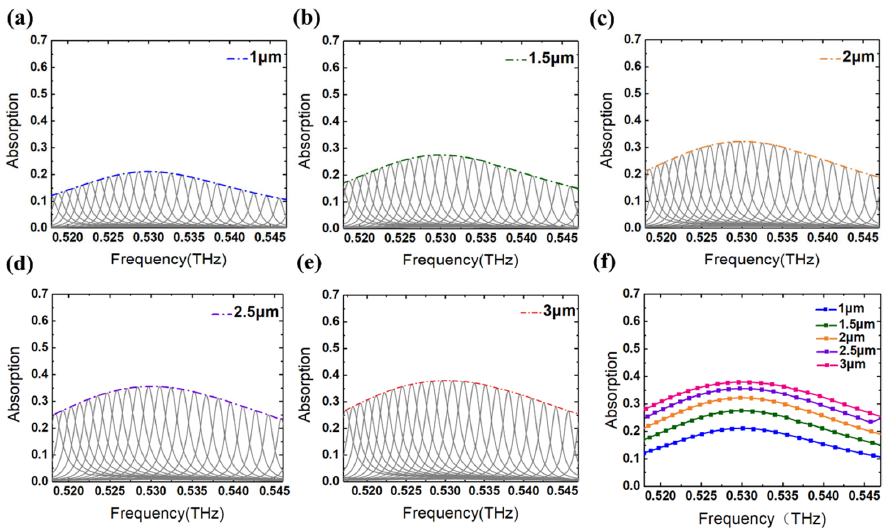
Figure 7. The enhanced absorption spectrum of the dielectric metasurface coated with different thicknesses of lactose. ( a ) 1 µm; ( b ) 1.5 µm; ( c ) 2 µm; ( d ) 2.5 µm; ( e ) 3 µm; ( f ) Comparison results.